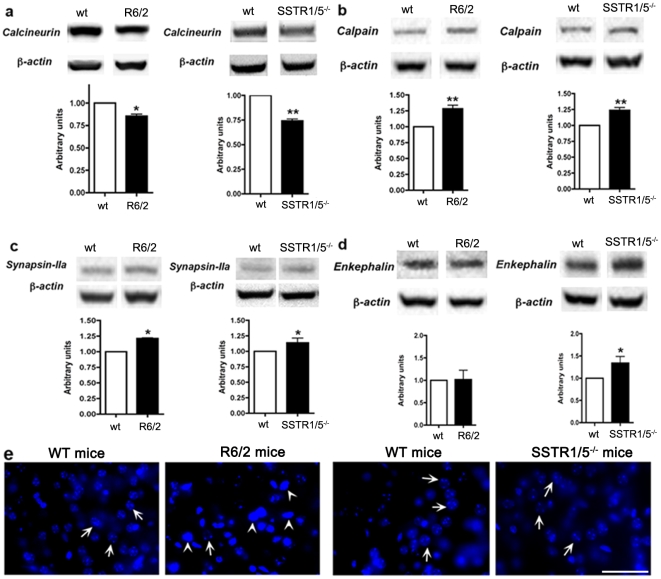
Western blot analysis demonstrating the changes in expression of calcineurin (61kDa), calpain (90 kDa), synapsin-IIa (74 kDa) and enkephalin (55 kDa) in tissue lysate prepared from striatum R6/2 and SSTR1/5−/− mice.Note the loss of calcineurin in SSTR1/5−/− and R6/2 mice brain striatum (a) and increased expression of calpain and synapsin-IIa (b,c). In contrast enkephalin was not changed in R6/2 mice whereas increased in SSTR1/5−/− mice brain (d). Data presented as mean ± SD (SSTR1/5−/−, n = 5 and R6/2 mice, n = 3) in comparison to wt mice brain. *P<0.05, ** P<0.01. e) Photomicrographs showing apoptosis in R6/2 and SSTR1/5−/− mice striatum. R6/2 transgenic mice displayed significantly increased number of apoptotic neuronal cells in striatum when compared to wt
(e panel left). Unlike R6/2 mice, only few apoptotic neuronal cells were observed in SSTR1/5−/− mice (e panel right). Arrows represent surviving cells and arrowheads represent apoptotic cells. Scale bar = 20 µm.